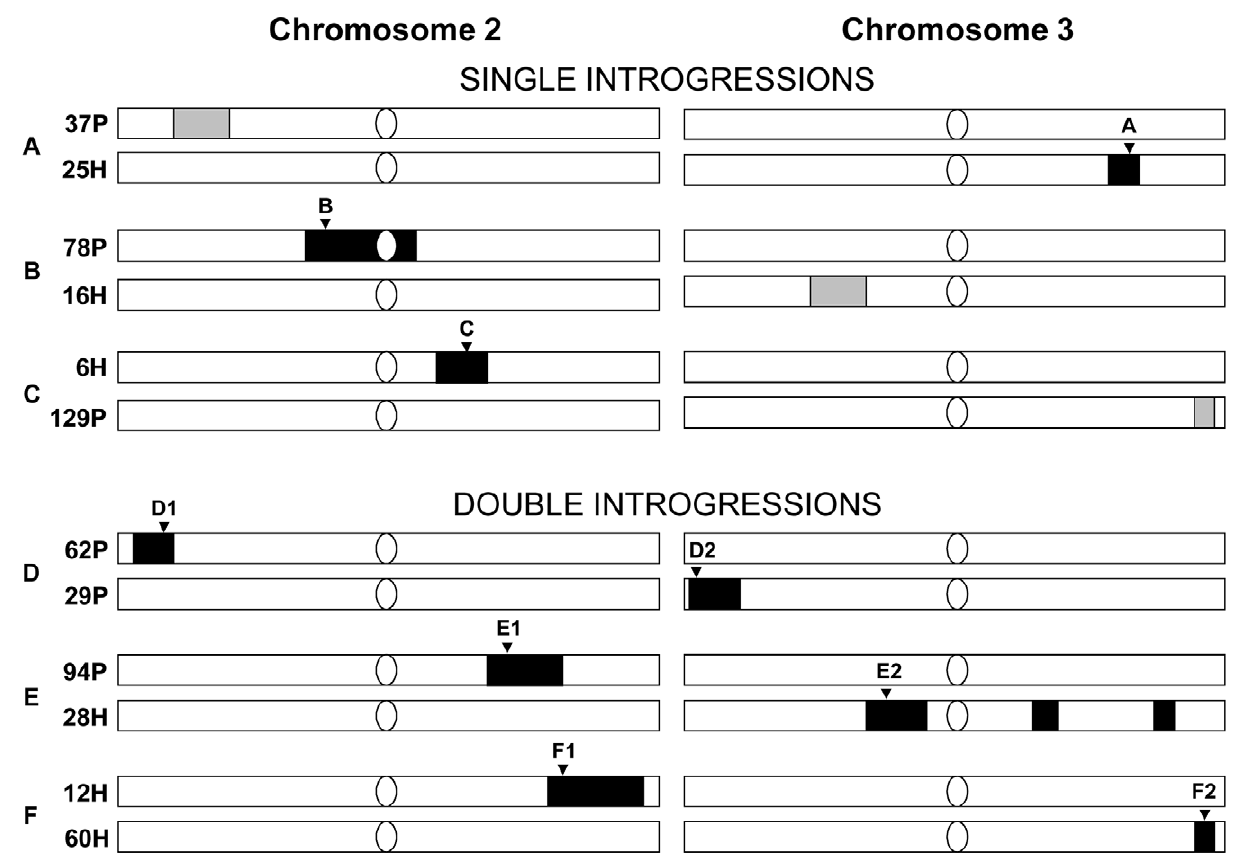
Figure 1. The introgression lines for establishing initial generation of six cross sets for competition experiments. The light bars represent simulans chromosome II or III, and the dark blocks represent sechellia introgression regions. Confirmed introgressions are shown in black. Unconfirmed introgressions are shown in grey. Microsatellite markers tracked in the experiment are labeled by the inverted triangles: A: DMU25686 (cytological position: 93F14); B: DRODORSAL (36C8); C: DROGPAD (47A9); D1: AC005732 (cytological position 24C9); D2: DMRHO (62A2); E1: DMMP20 (49F13); E2: DMCATHPO (75E1); F1: DS00361 (54B5); F2: DMU43090 (99D5) [53,54] (see Materials and Methods for details of each marker and for single versus double introgression designs).